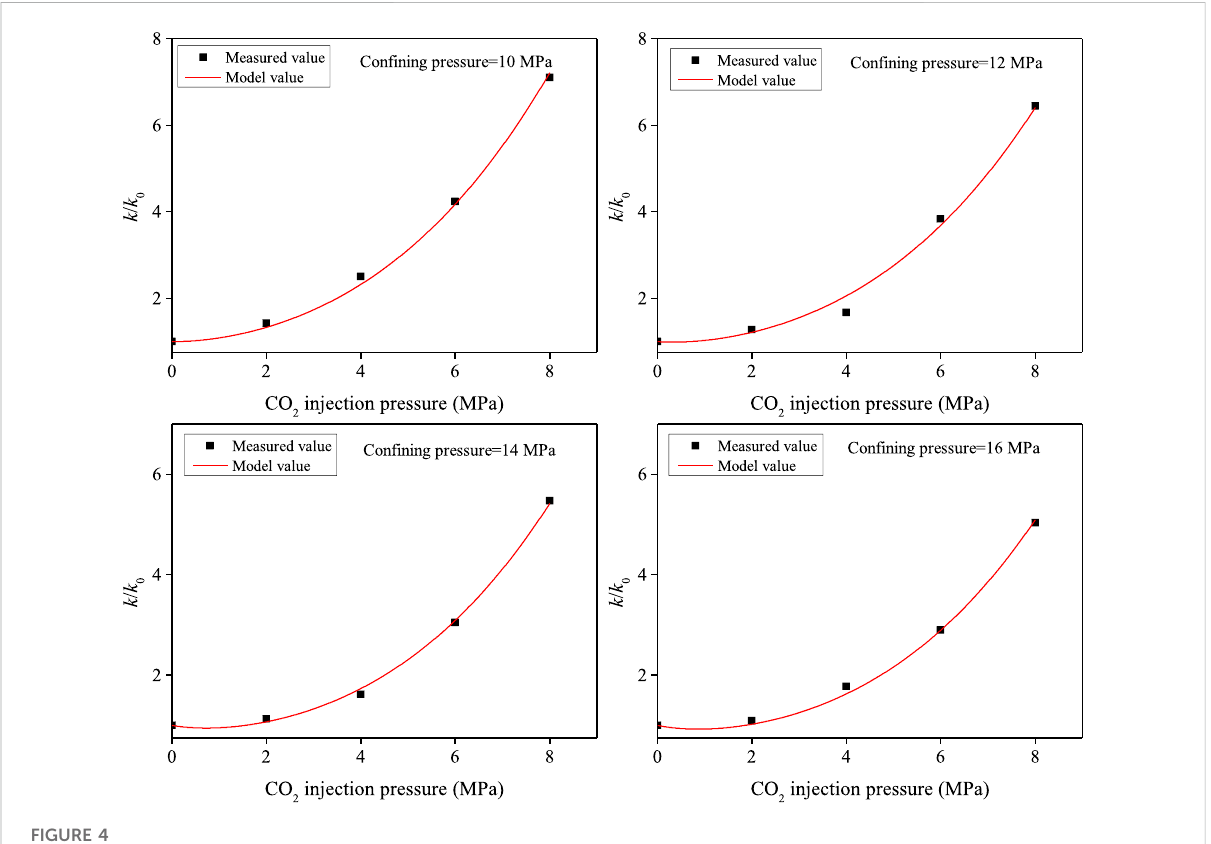
FIGURE 4 Fitting results of the permeability results of cylinder sample.